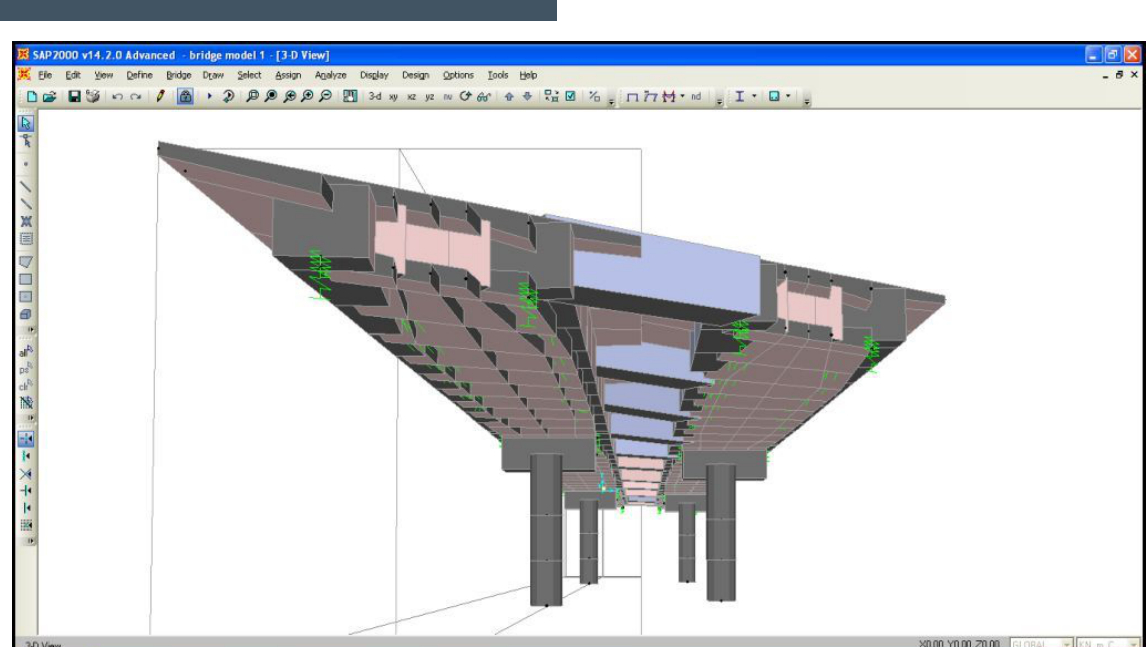
Figure 9. The bridge model after strengthening